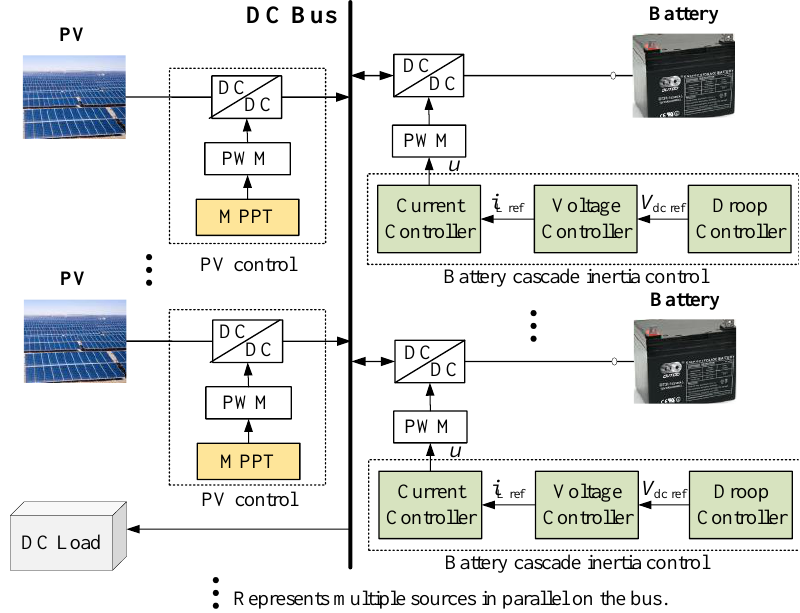
Figure 1. Overall control structure of PV-battery DC microgrid.